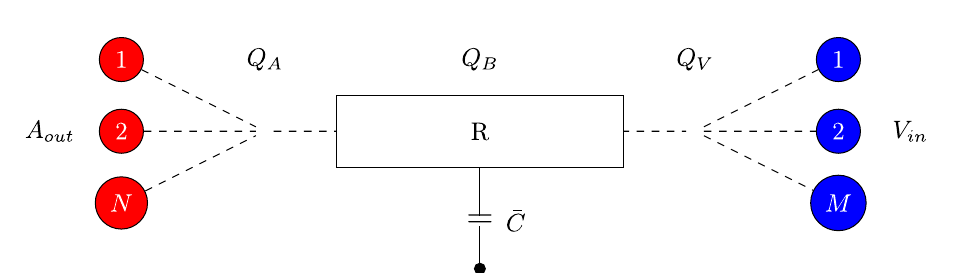
Figure 8. Conceptual layout of the resistor-capacitor based approach to representing the capillary beds. The arterial, Q A and venous, Q V flow through the bed is accumulated from and distributed to the connecting vessels by their relative portion of the total vessel area attached to the bed. The capacitance, average of arterial and venous vessel